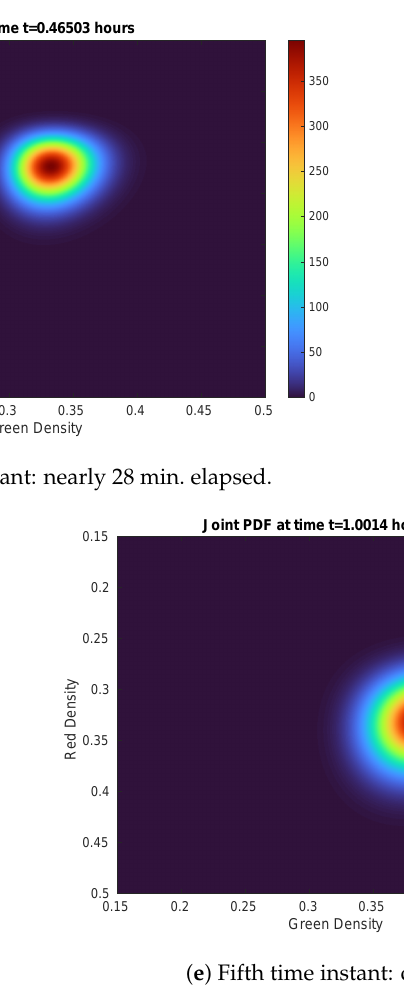
Figure 7. Joint 1-PDF evolution of the solution stochastic process in every time instant given by data from Table 1. It can be seen how variance, which is reflected by the width/height ratio, grows. Take into account that the color bar is not fixed and, therefore, it re-scales itself at every time